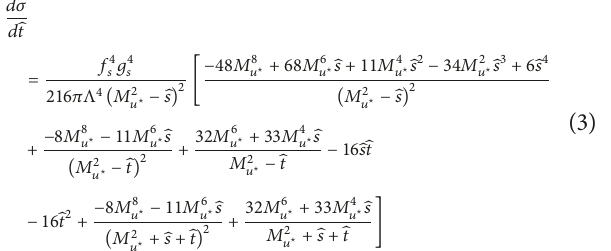
total decay widths are given for Λ = 𝑀 𝑑 ⋆ , Λ = 𝑀 𝑢 ⋆ , and Λ = 100 TeV by scanning excited quarks mass from 6 TeV to 100 TeV. Total decay widths of 𝑢 ⋆ and 𝑑 ⋆ are close to each other since dominant decay modes are 𝑢 ⋆ 󳨀→ 𝑔𝑢 and 𝑑 ⋆ 󳨀→ 𝑔𝑑